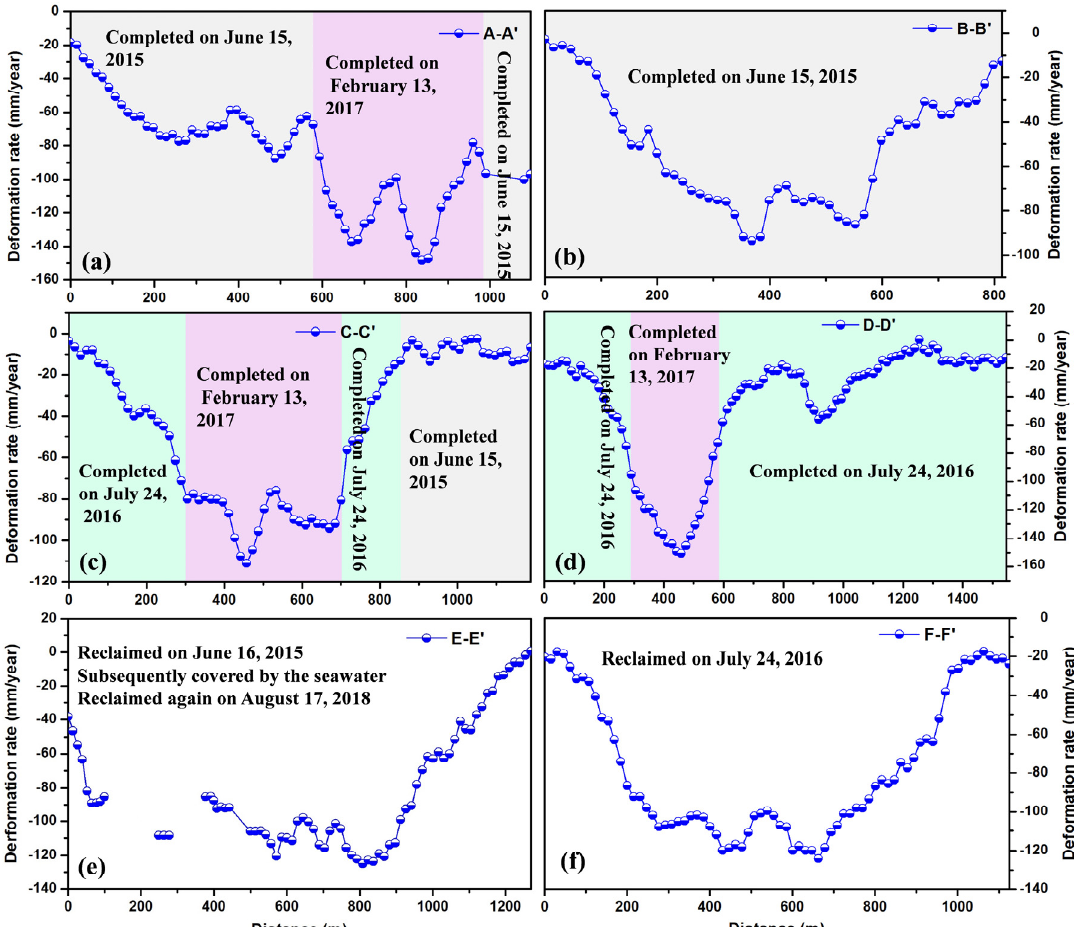
Figure 7. Cross-sections of average vertical deformation rates of Xiamen New Airport from January 2017 to October 2018 along six profiles, whose positions are marked in Figure 6. ( a ) Profile A–A’; ( b ) profile B–B’; ( c ) profile C–C’; ( d ) profile D–D’; ( e ) profile E–E’; ( f ) profile F–F’.